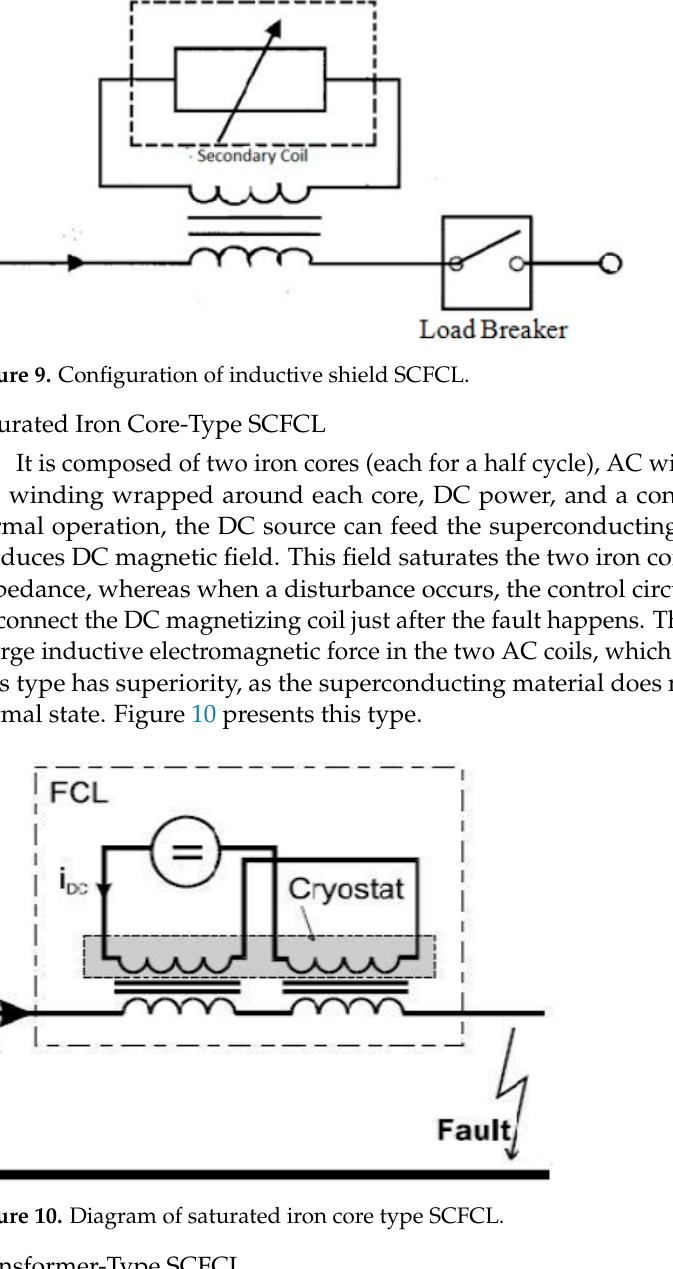
12 of 31 Figure 8. Non-inductive SCFCL in an electrical circuit. Inductive Shield SCFCL As shown in Figure 9, it is about the secondary side, which is the superconducting coil (SC coil) and the bypass winding lapped around the iron core, and the primary side as the power line [38]. During the normal operation, where the material appears in its superconducting state, the secondary coil shields the iron core from the primary coil.